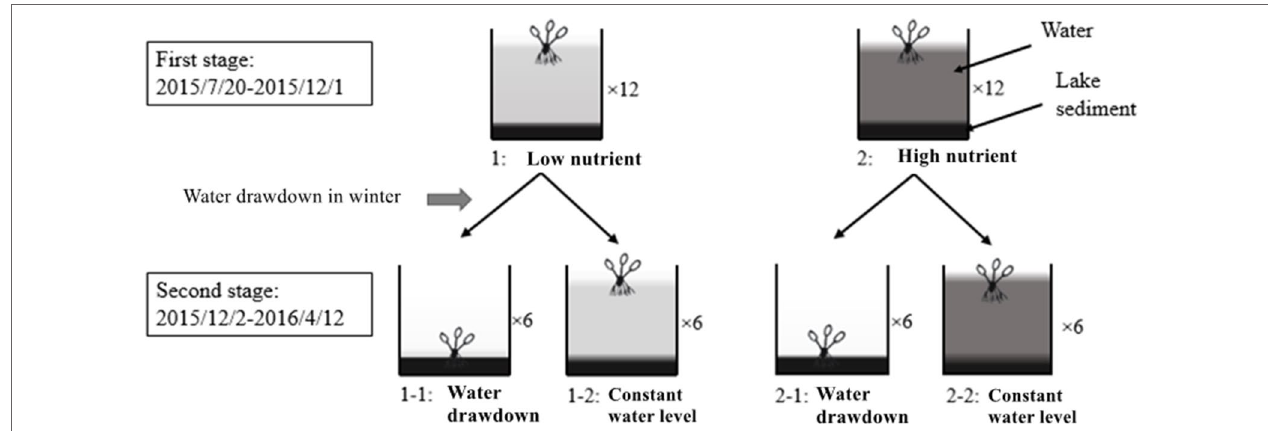
FIGURE 1 | Diagram of the experimental design (the number following the “×” indicates the number of replicates. One plant in diagram represents